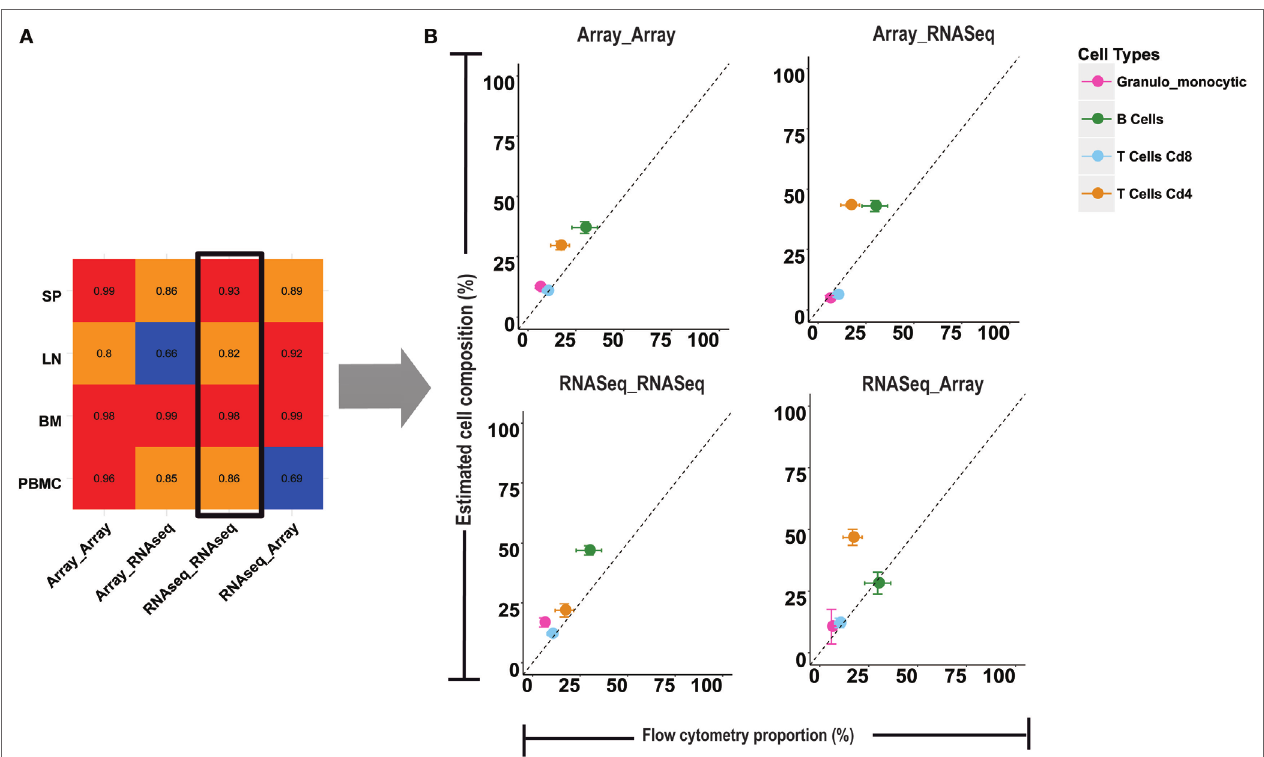
FIGURe 3 | Comparison of microarray and RNA-seq based deconvolution models. (A) Four cross models with microarray or RNA-seq data as the training or testing input were compared. The value in the heatmap is the Pearson correlation coefficient between the results from four computational models and flow cytometry in four tissues. (B) The error bar plots are the comparison of the RNA-seq training and testing model with the flow cytometry for granulo-monocytic cells, CD4 T cells, CD8 T cells, and B cells in peripheral blood mononuclear